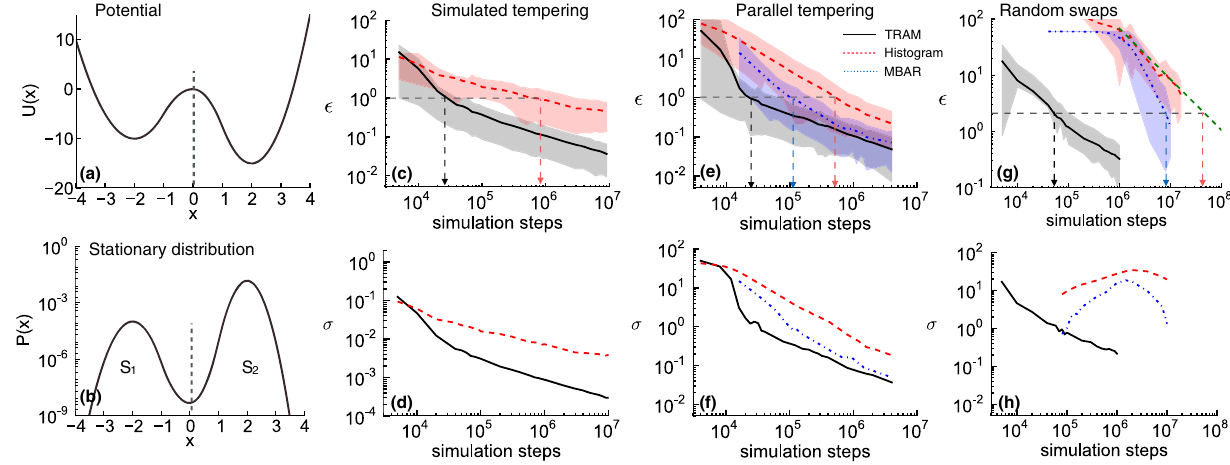
T ¼ 1 . (c, d) Results of B